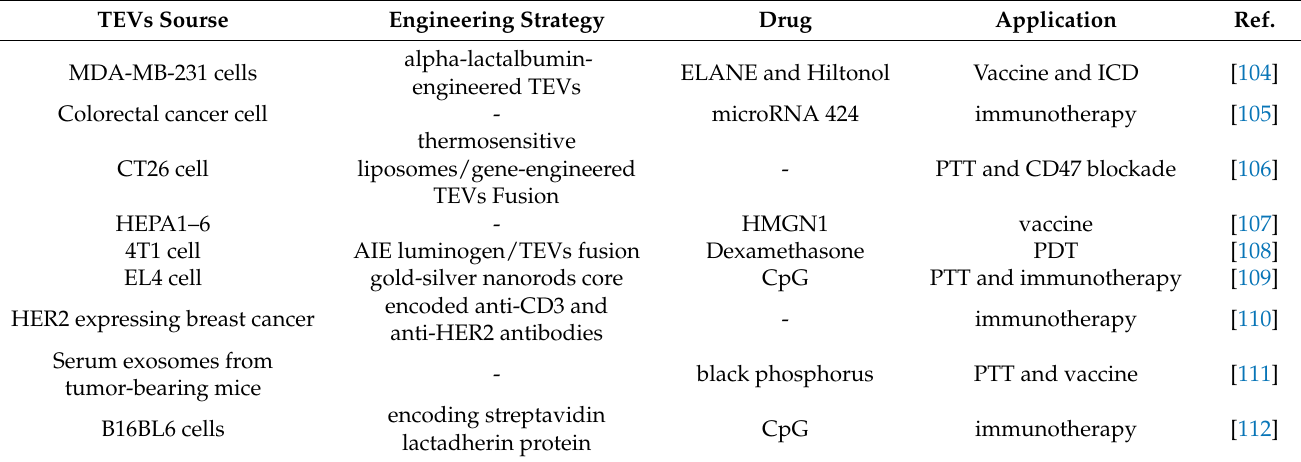
Table 3. Representative applications of TEVs in tumor